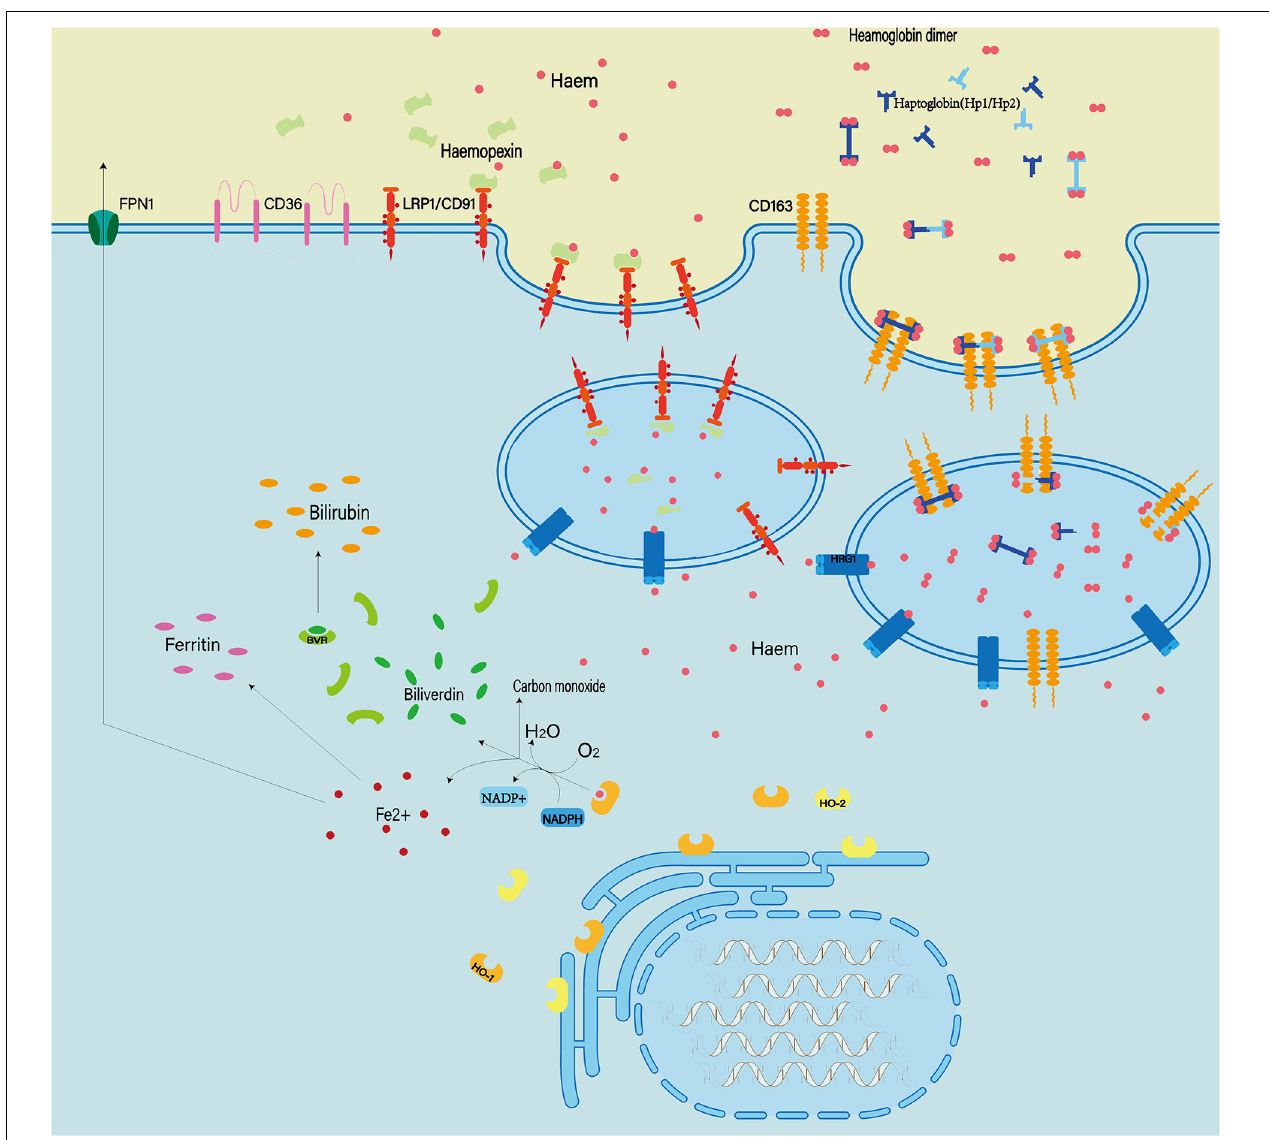
FIGURE 7 | Extracellular hemoglobin can be metabolized into hemoglobin dimer as well as heme. The hemoglobin dimer can bind to the haptoglobin and enter the cell mediated by CD163. Soon afterward, the hemoglobin dimer that enters the cell will be decomposed into heme. On the other hand, extracellular heme can bind to hemopexin and enter the cell mediated by CD91. In quick succession, heme and oxygen in the cell are catalyzed by heme oxygenased (HO1/2) to produce Fe 2 + ions, CO and bilirubin. In addition, abnormal red blood cells can also be cleared by phagocytosis mediated by the expression of type II scavenger receptor (CD36) on the phagocytic